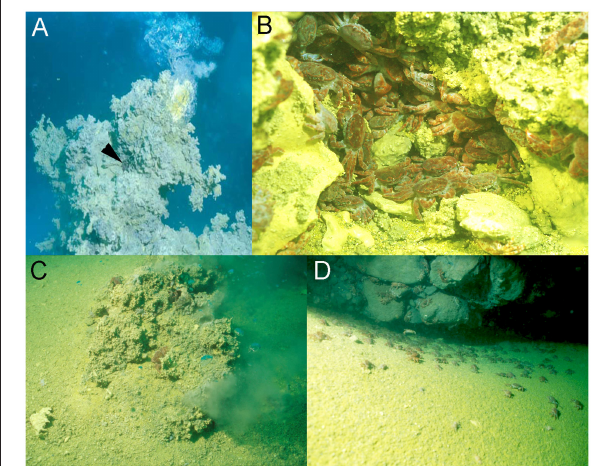
FIGURE 1 | Xenograpsus testudinats crabs in the hydrothermal vent habitat at Kueishan island located off Taiwan’s east coast. Underwater photographs of the hydrothermal vent system at Kueishan island, showing an active chimney discharging acidic, CO 2 rich water (note the X. testudinatus crab in the direct vicinity of the vent opening) (A) . High densities of X. testudinatus crabs can be found in the direct surrounding of the vents hiding in sulfur-rich crevices (B) . Whilst feeding on zooplankton killed by the toxic discharges of the vents crabs swarm out of their shelters, and are directly exposed to highly acidic waters (C,D) . All images were obtained and authorized from the co-author Dr. Ming-Shiou